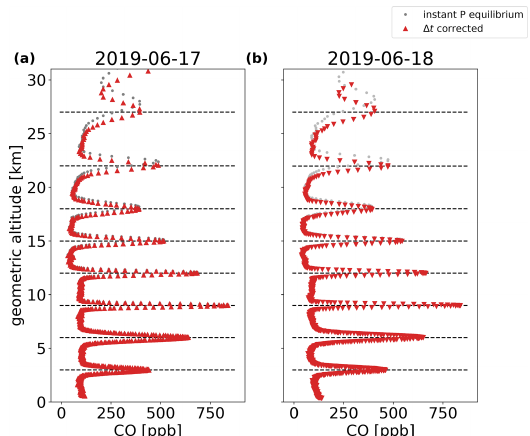
Figure 6. Time lag (cid:49)t between retrieved geometric altitude and signal release GPS altitude.